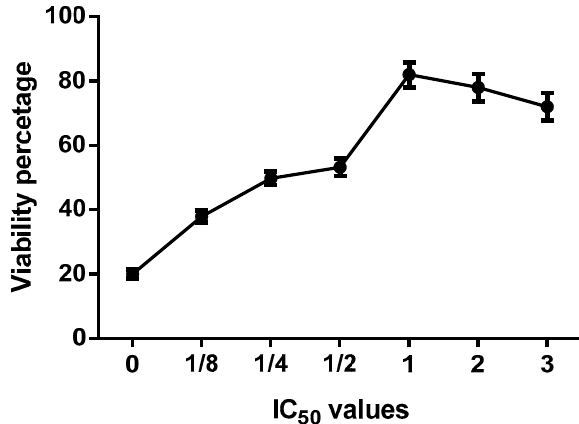
Figure 8. Extract 80% EtOH effect on cell survival. Groups of cells were treated with 1 mM of H 2 O 2 to induce oxidative stress for 24 h at 37 ºC with 5% CO 2 . After this incubation, the cells were treated with extract 80% EtOH at different IC 50 values were assayed to determine the viability percentage as (SD)) from three di ff erent described in Materials and Methods. Each point corresponds to the results (mean ± standard deviation (SD)) from three different preparations.